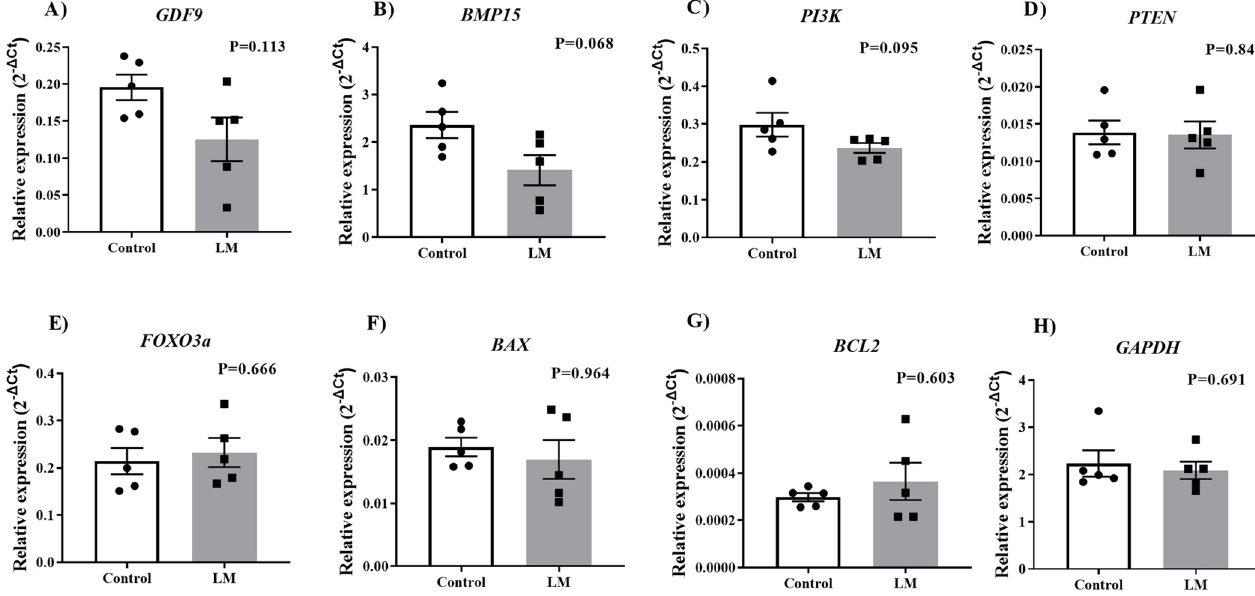
Fig 5. Target transcript analysis in oocytes. Relative expression of A) GDF9; B) BMP15 ; C) PI3K; D) PTEN; E) FOXO3a; F) BAX; G) BCL2 and; H) GAPDH genes in oocytes matured for 22h conventional or LM systems (n = 10 oocytes/replicate, 5 biological replicates). Statistics was performed using Student’s t test, no statistical difference was found between the groups (P > 0.05). Standard bars represents the